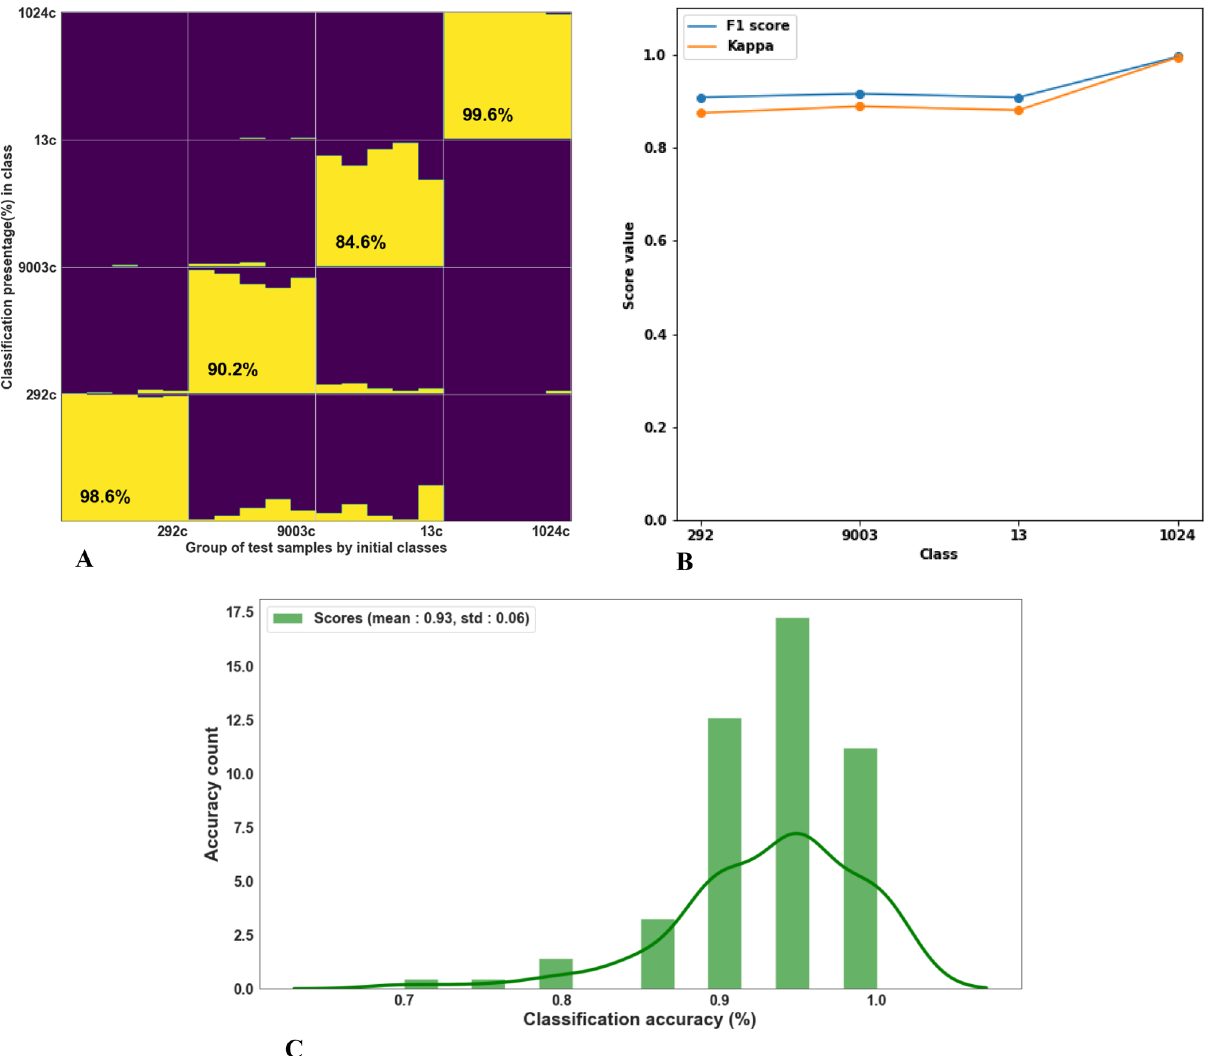
Figure 5. Classification of charred pips using a charred training set. ( A ) Accumulative distribution of LDA classification after running 100 tests. At each run, ten random pips from the assemblage were selected as the training group, and the other remaining five pips were classified, ( B ) F1 and Kappa scores of random charred vs charred data splits with 100 iterations, ( C ) Classification score histogram—100 training [10 burned samples] and independently 100 tests for each pip [5 burned